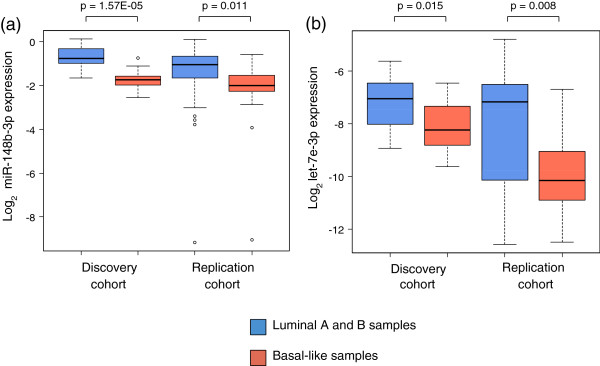
miRNA expression in luminal and basal-like patients. miRNA expression when patients were divided into luminal and basal-like subgroups in the discovery and replication cohort. (a) miR-148b-3p expression, (b) let-7e-3p expression. The P-values are from Wilcoxon rank-sum tests.